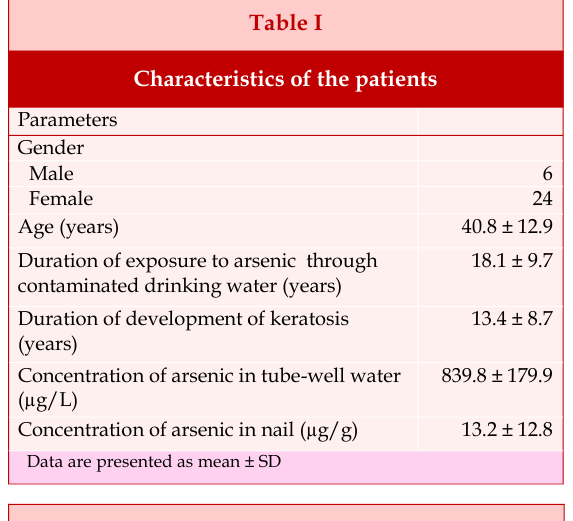
Palmar skin swab of the patients revealing the growth of bacteria and